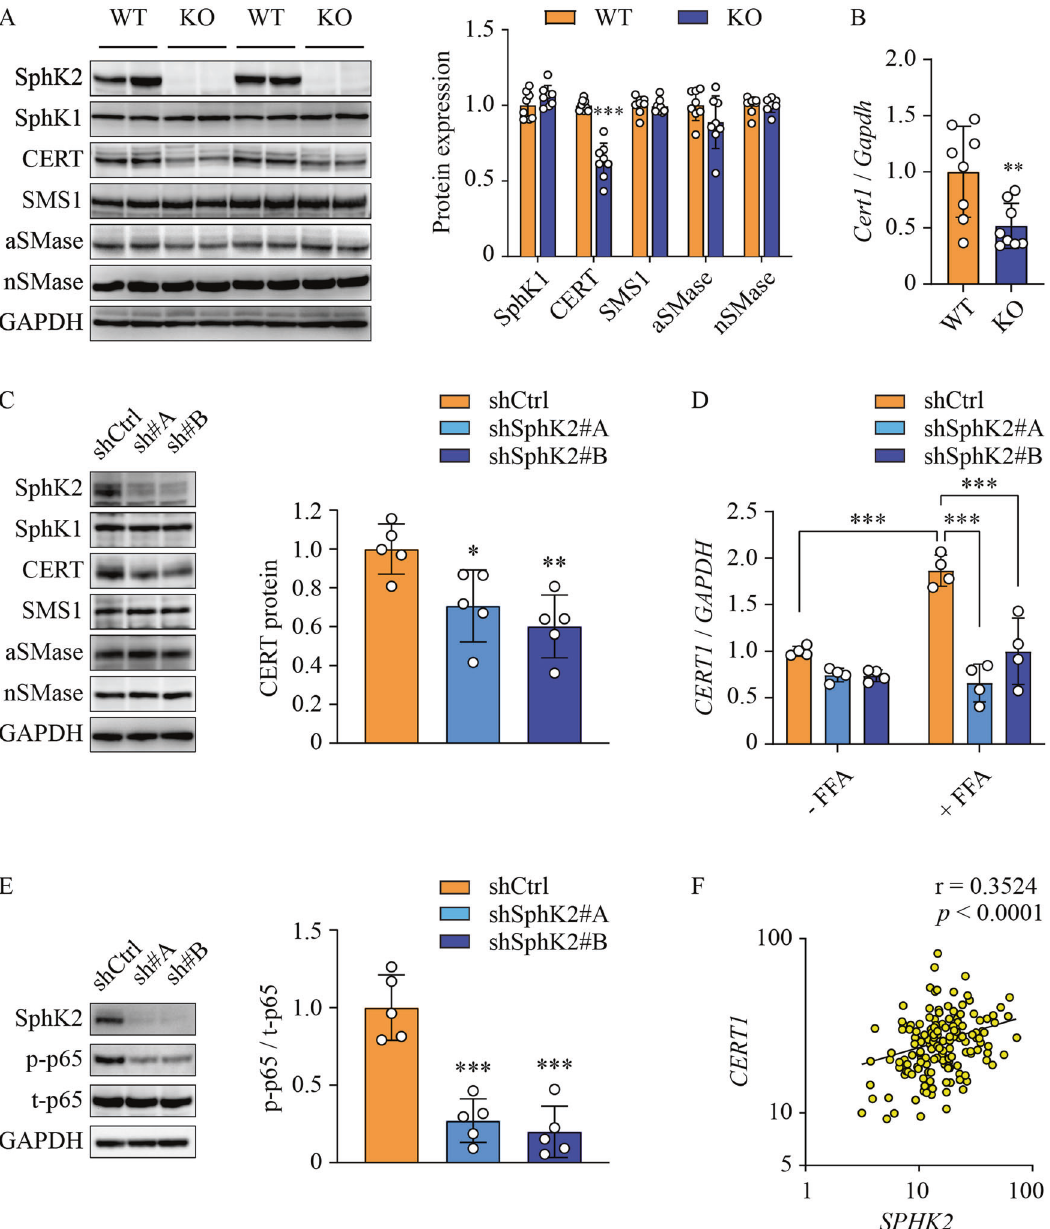
Fig. 5 SphK2 de fi ciency downregulates CERT both in vivo and in vitro. A , B Wild-type (WT) and Sphk2 knockout (KO) mice were fed with a high-fat, high-sugar diet (HFHSD) for 46 weeks. A Proteins were extracted from non-tumorous liver tissues and analyzed using Western blotting. Expression levels of the indicated proteins were quanti fi ed; n = 8. B mRNA expression of Cert1 , the gene encoding mouse CERT, was examined by real-time RT-PCR; n = 8. C – E Huh7 hepatic cells were transduced with lentiviral-based short hairpin RNA (shRNA) to knock down SphK2 and then treated with a combination of free fatty acids (FFA, 200 µM palmitate + 400 µM oleate) for 48 h. C , E Proteins were extracted from cells and analyzed using Western blotting. The CERT protein expression and phospho-p65 over total p65 (p-p65/t-p65) were quanti fi ed; n = 5. D mRNA expression of CERT1 , the gene encoding human CERT, was examined in the presence and absence of the FFA treatment by real- time RT-PCR; n = 4. A – E Data are expressed as mean ± SD. * p < 0.05; ** p < 0.01; *** p < 0.001; versus control. F The correlation of SPHK2 and CERT1 mRNA expression was analyzed in human HCC subjects with body mass index > 25. Data are sourced from TCGA (https://